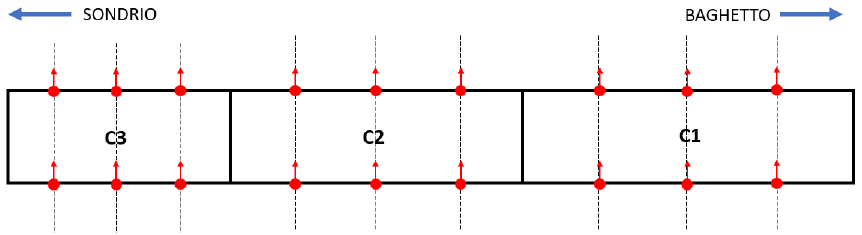
Figure 8. Measurement set up adopted during the experimental field tests on the Baghetto Bridge. The spans are numbered in ascending order from Baghetto to Sondrio. Instrumentation consisted of 24-bit resolution DAQs and high-sensitivity (10 V/g) piezo-electric accelerometers and servo accelerometers. The sensing devices featured a measurement range of 0.5 g pk and a frequency range ( ± 3 dB) from 0.05 to 4000 Hz.